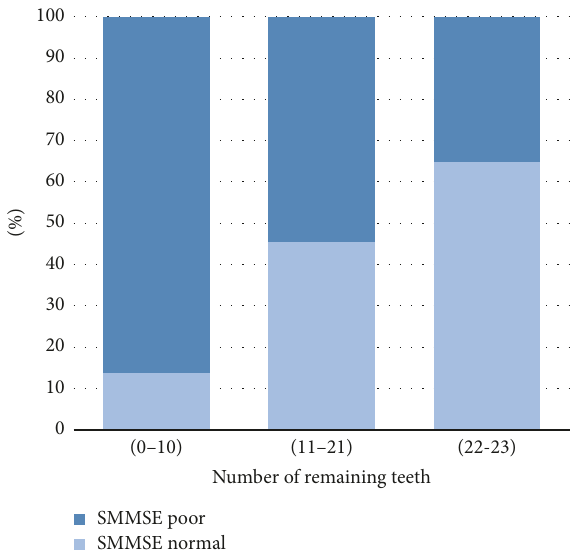
Figure 2: Prevalence of normal SMMSE or low SMMSE score according to chewing